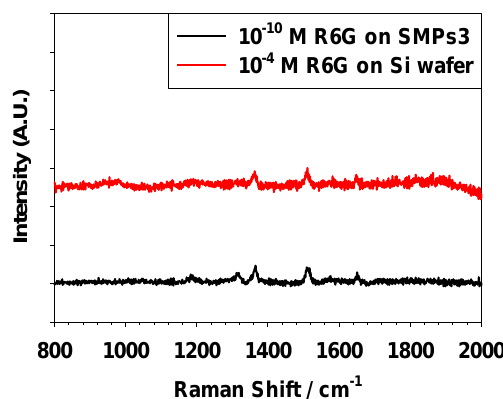
Figure 6. SERS spectra of rhodamine 6G adsorbed on SMPs3 and on planar Si surface. Intensity ratio of two spectra implies an EF of ~10 6 .